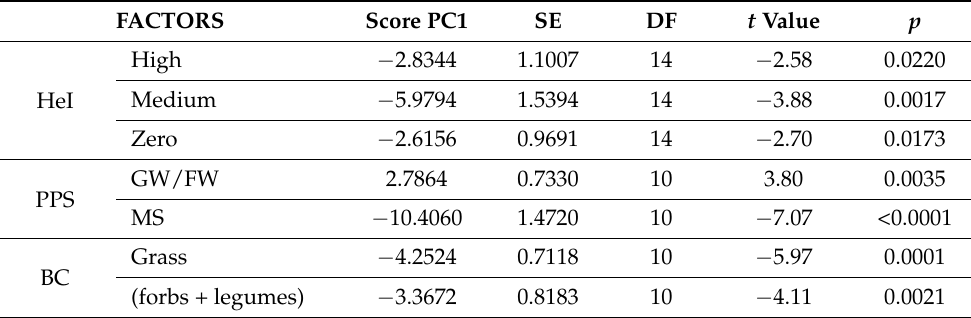
Table 3. p values, standard error (SE), degree freedom (DF), and t value of PC1 estimated score values, performed by a GLM repeated measures procedure for the factors of herbage intake (HeI), plant phenological stage (PPS), and pasture botanical composition (BC).